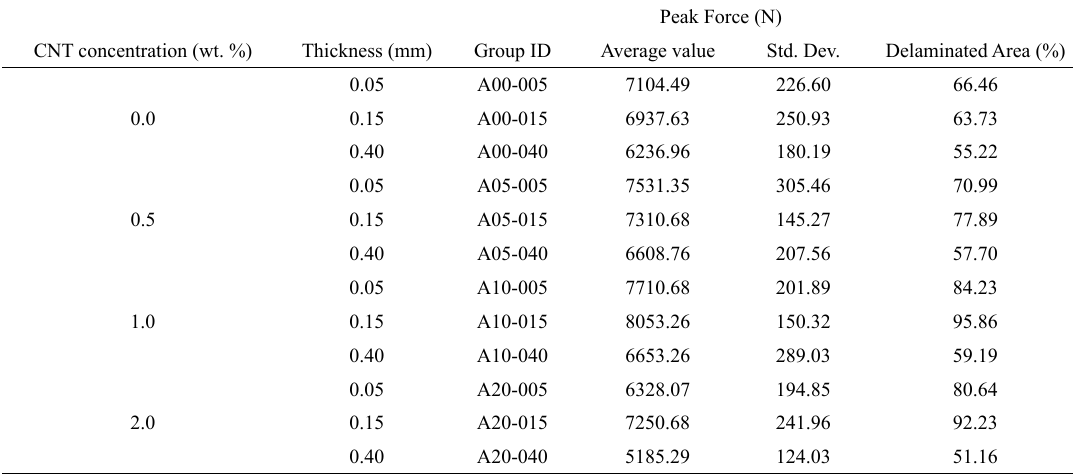
Table 2 summarizes the mechanical strength and